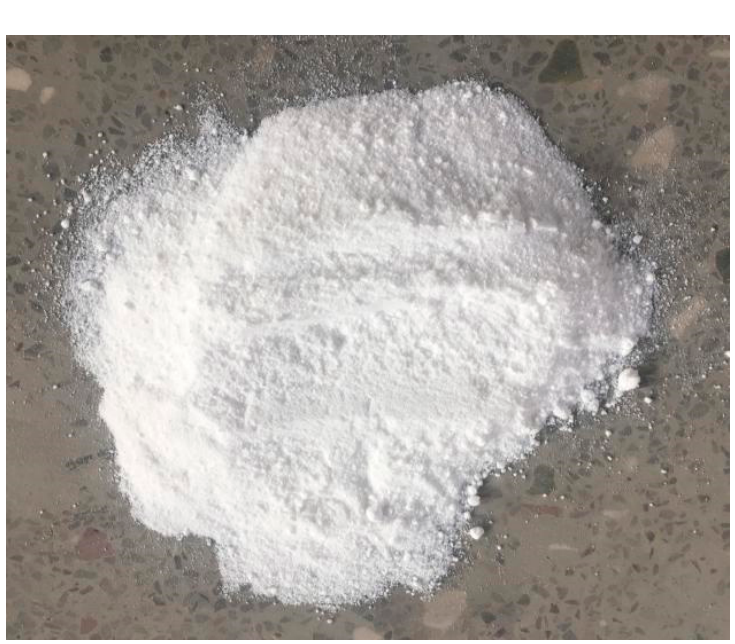
Figure 1. Appearance of powdery nanosilica (NS). A laser diffraction-type particle size analyzer (Microtrak-9320HRA, Aichi-ken